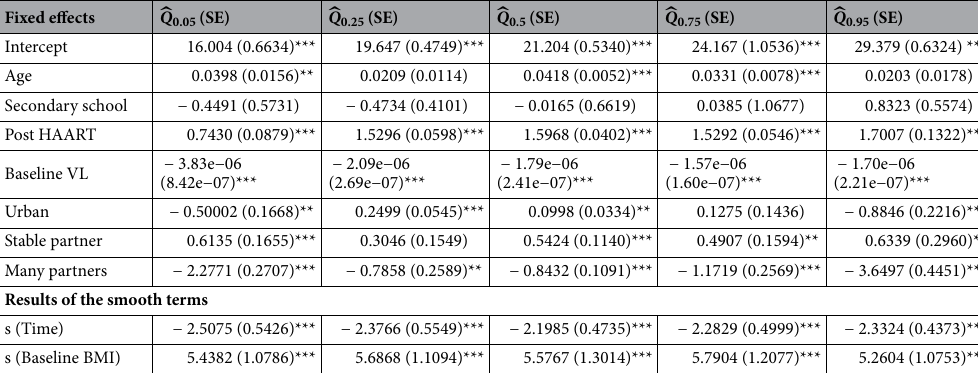
Table 3. Parameter estimates followed by results of the smoothing terms from the AQMM for the CAPRISA 002 AI study data across different quantiles. *Significance codes: 0 ‘***’, 0.001 ‘**’, 0.01 ‘*’, 0.05 ‘.’, 0.1 ‘ ’, 1. The reference categories are given in Table 2.